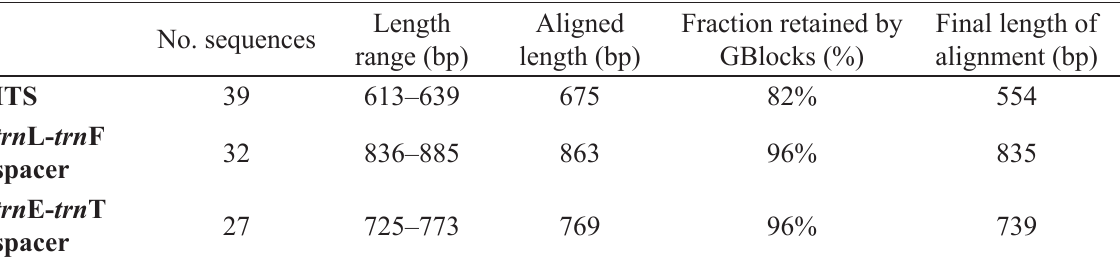
Table 1. Nucleotide sequence characteristics of the gene regions